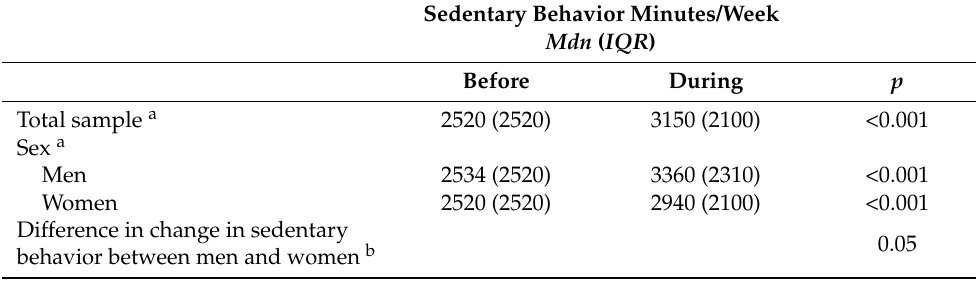
Table 3. Sedentary behavior before and during the pandemic for the total sample and in relation to sex and